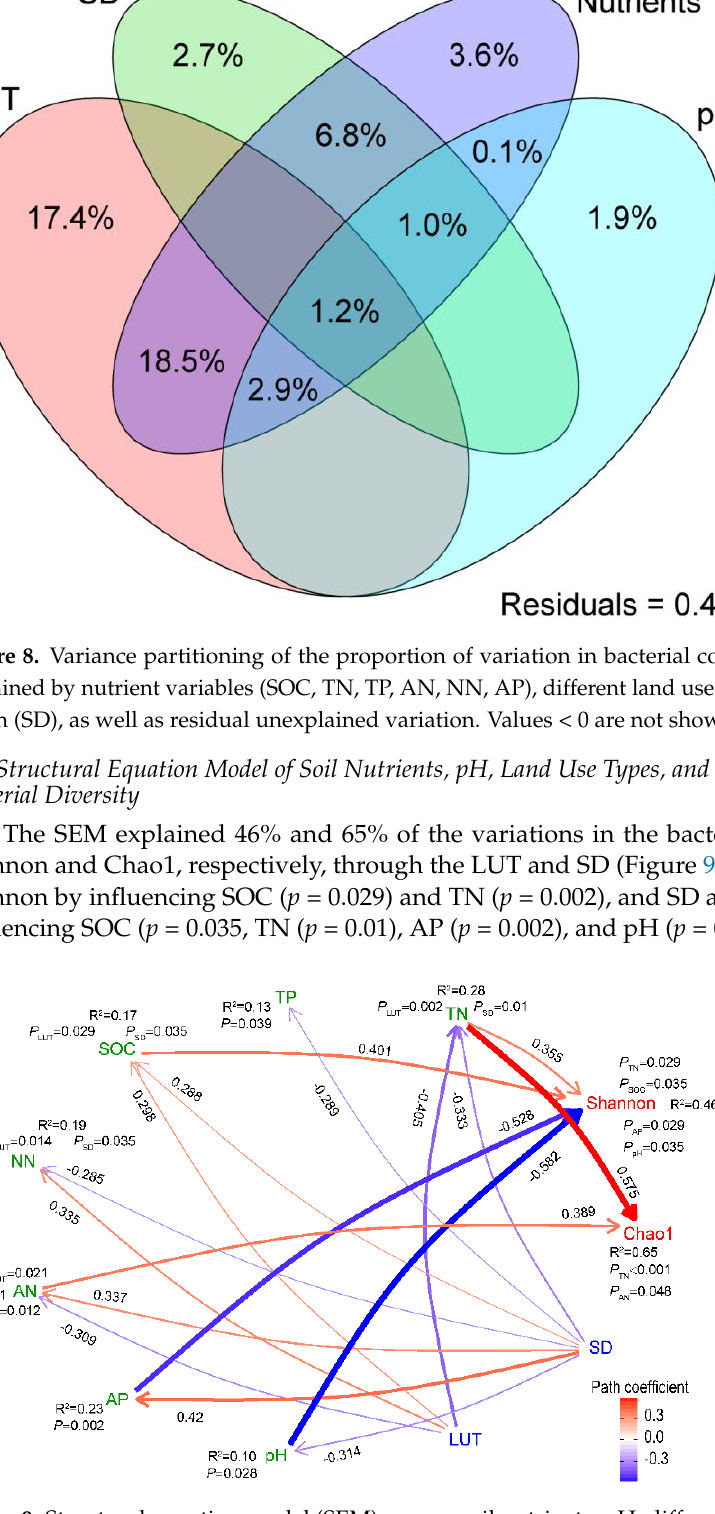
Figure 9. Structural equation model (SEM) among soil nutrients, pH, different land use types, soil depth, and bacterial community diversity.